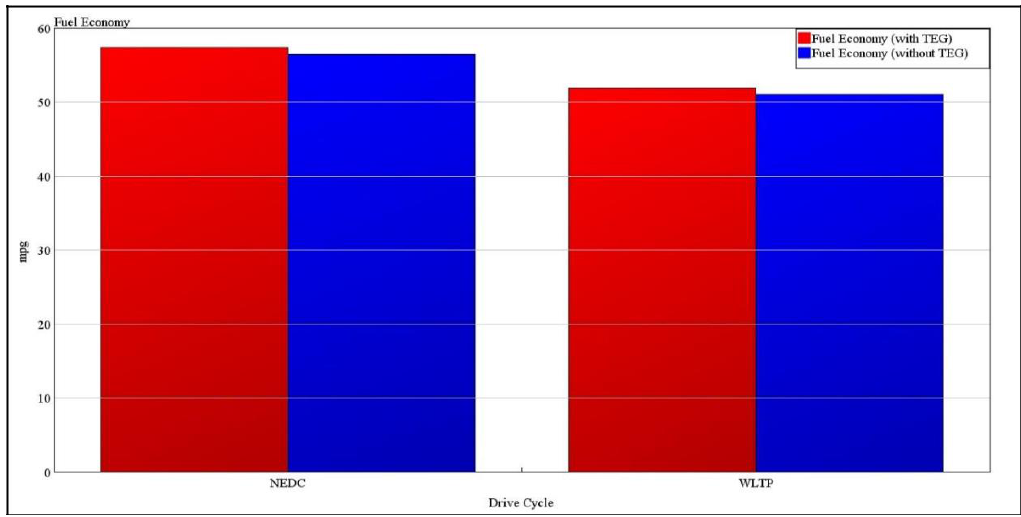
Figure 32. Fuel economy.